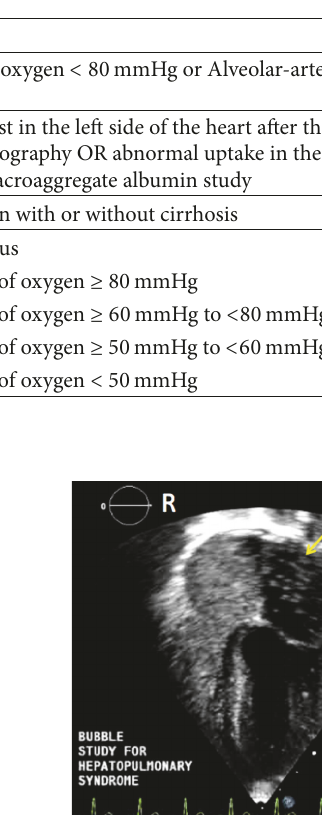
Table 1: Hepatopulmonary Syndrome diagnostic criteria.